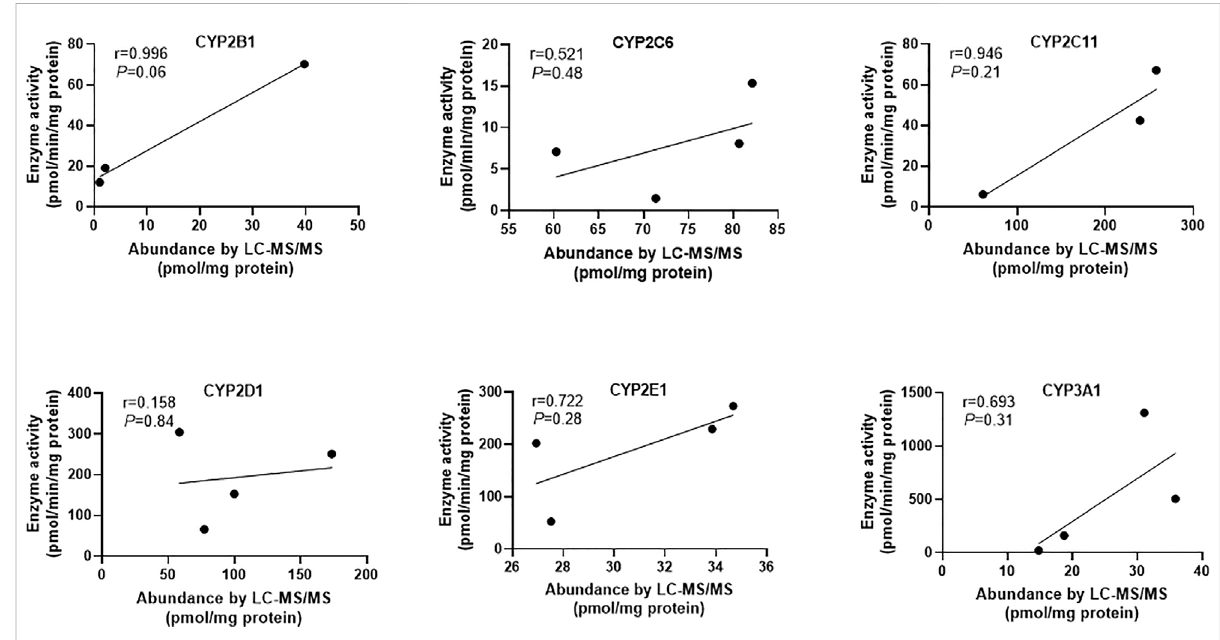
FIGURE 3 The correlation analysis between protein abundance by LC-MS/MS and enzyme activity of six CYP enzymes. Since the protein amounts of CYP1A2 from different sources were lower than the lower limit of quanti fi cation, the correlation analysis between its content and activity has not been carried out. Pearson correlation analysis was performed and p < 0.05 was considered statistically signi fi